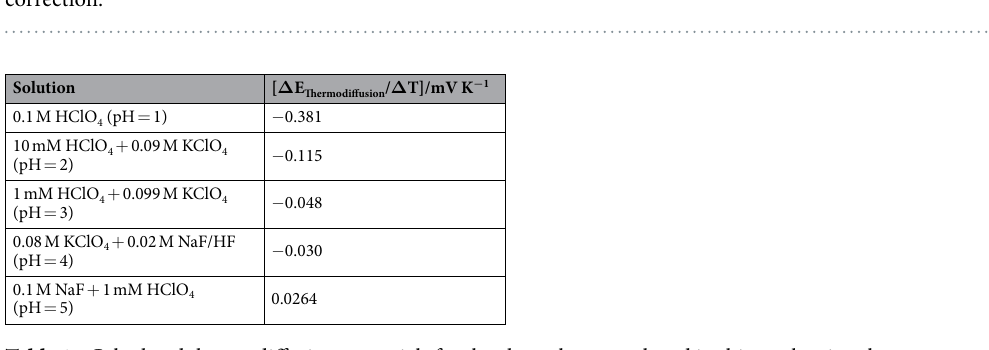
observations suggest that the “H-upd region” does not only involve hydrogen adsorption, but the specific adsorp- tion of hydroxide-ions as well. The interface between Ir(111) and sulfuric acid electrolytes was also investigated by means of LIPT in order to elucidate the influence of sulfate specific adsorption on the restructuration of the interfacial H 2 O-network. Figure 7 shows the laser induced potential transients for Ir(111) electrodes in contact with sulfate containing electrolytes at pH = 1, pH = 2, and pH = 3. Our measurements show that in these systems the PME is located at the onset of the sulfate adsorption and shifts by around 30 mV in the RHE scale per pH unit, similar to the voltammetric peaks (see Figs 3 and 7 respectively). Thus, the adsorption of sulfate-anions takes places when the surface is positively charged, if we accept the correlation between PME and E PZFC . The potential transients, how- ever, become negative again at ~100 mV at pH = 1, ~140 mV at pH = 2 and ~170 mV at pH = 3 in the RHE scale, therefore after the large peak related to sulfate adsorption (see Figs 3 and 7). The change of the sign of the tran- sients takes place at much lower potentials in the sulfate/sulfuric electrolytes compared to perchlorate/fluoride ones, indicating that the sulfate-surface interactions are stronger than interactions between the hydroxide-ions and Ir(111). Therefore, the adsorption of sulfate-anions causes a strong change on the surface polarization reor- ienting the water molecules. An analogous effect of sulfate adsorption on the interfacial water restructurisation was previously reported for Au(111) and Pt(111) electrodes 27, 28 .